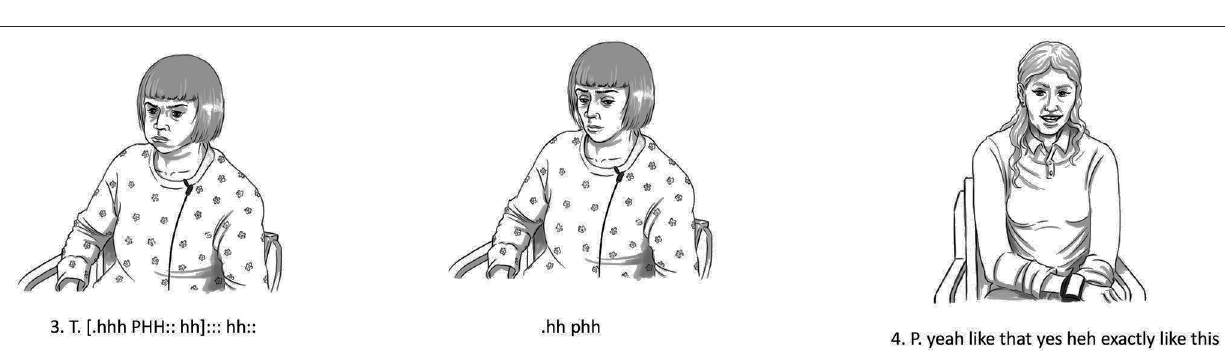
FIGURE 4 | Bodily actions in relation to example